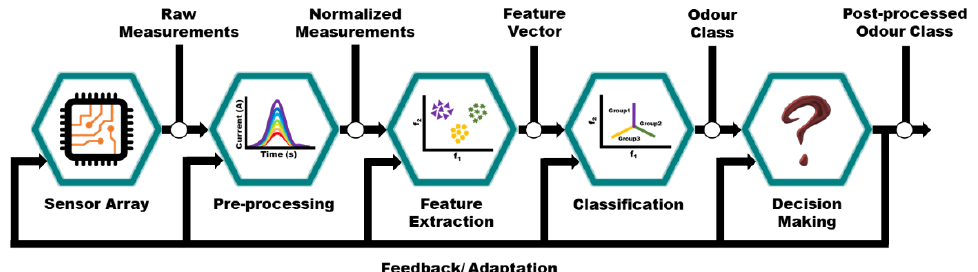
Figure 6. Block diagram representing signal processing architecture in an Enose. Pre-processing: collects data and converts to specific pattern. Feature extraction: extraction of robust and fingerprint information. Classification: grouping the extracted information into classes. Decision making: analysis of type and concentration of vapours.